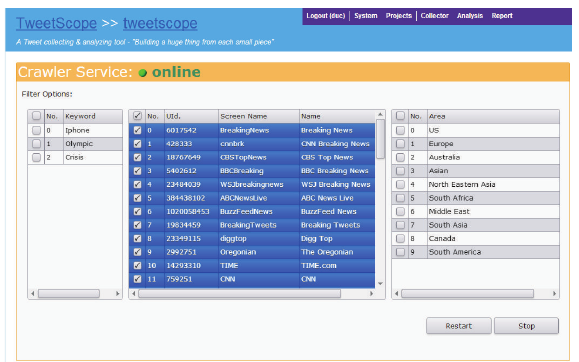
Figure 2: Example about demand to monitor and aggregate infor-